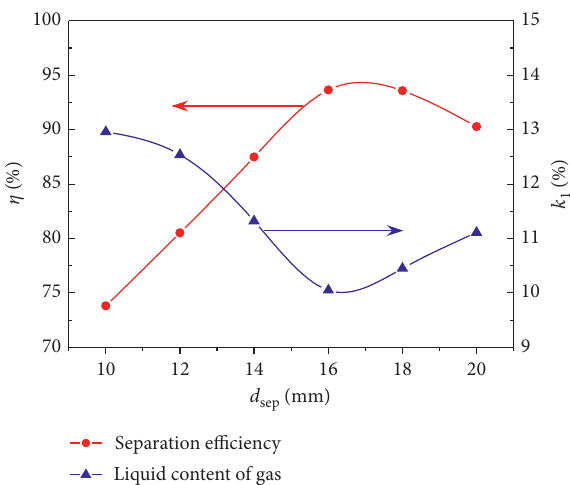
Figure 13: Effect of cylinder diameters on separation efficiency and gas-liquid content.